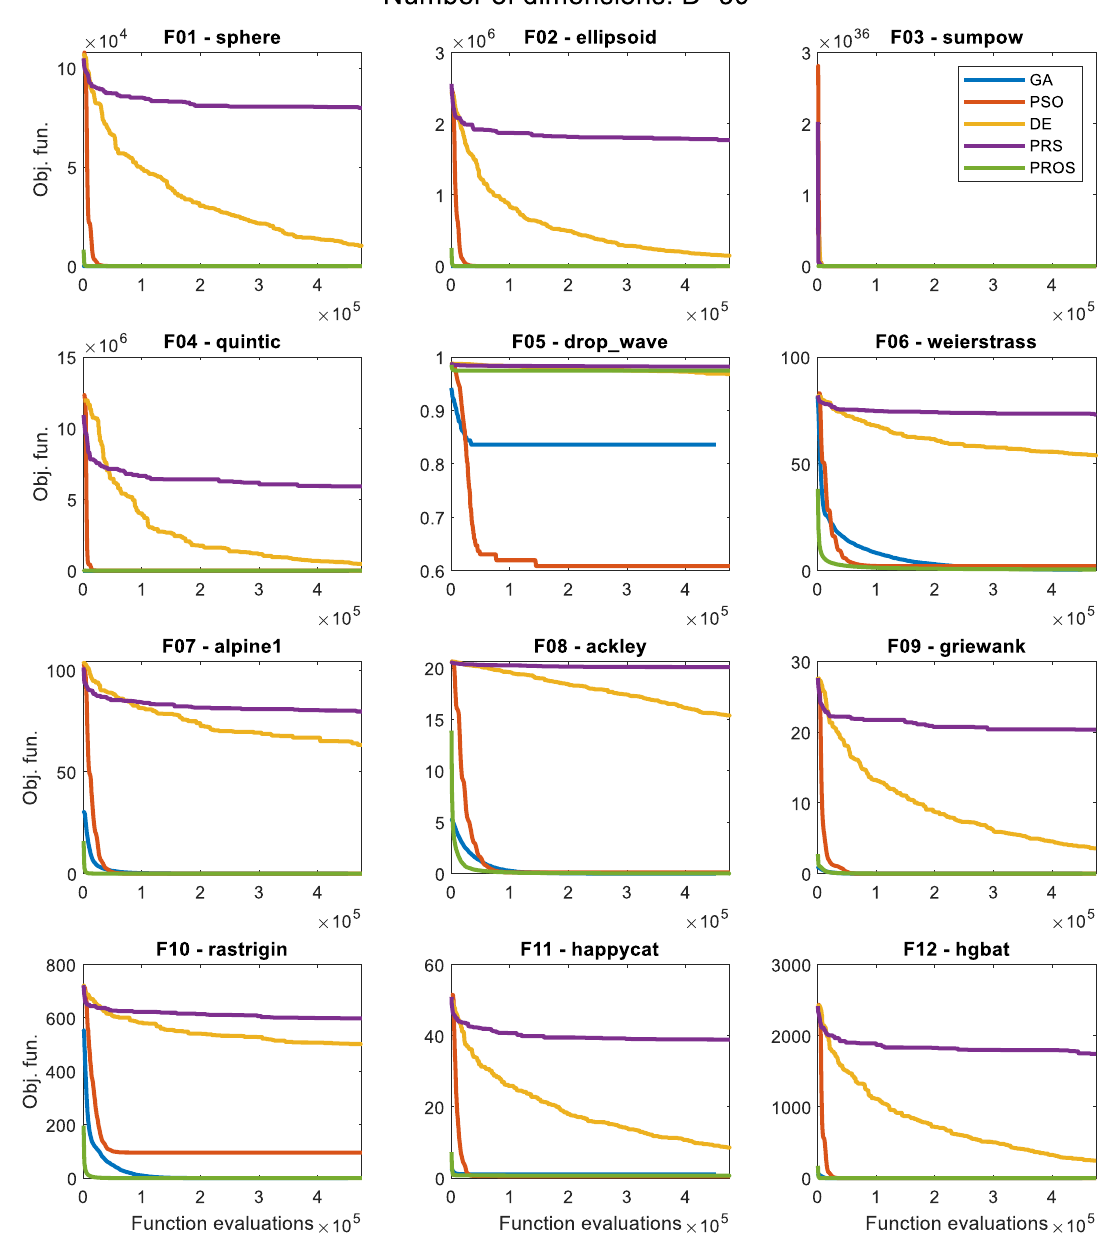
Figure 8. Convergence history of the various optimizers for 50 dimensions ( D = 50), for all 12 objective functions (average of 10 runs).